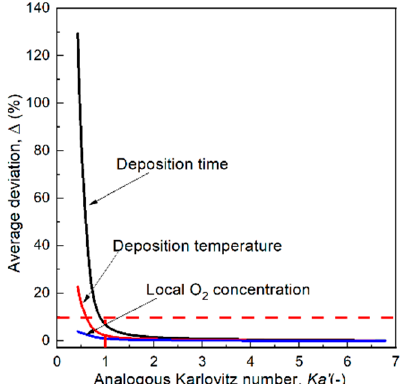
Figure 14. Relation between the average deviation of deposition parameters and analogous Karlovitz